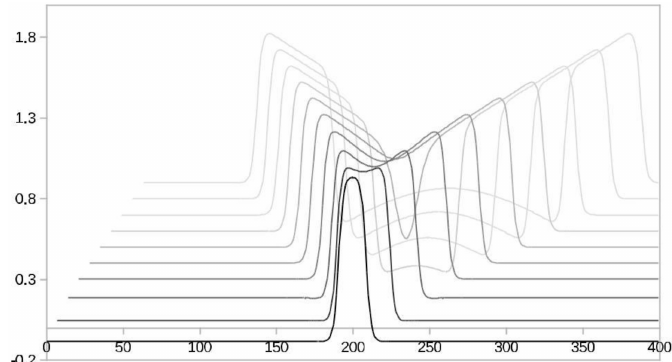
Figure 1. An FHN activator neuron’s initial spike splits and spreads in time. The time delays are visible by decreasingly paler black